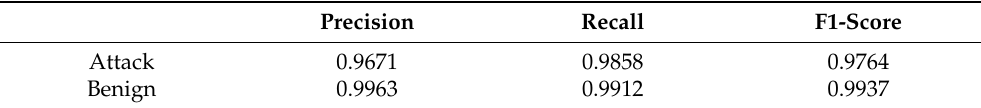
Table 4. Evaluation metrics for the